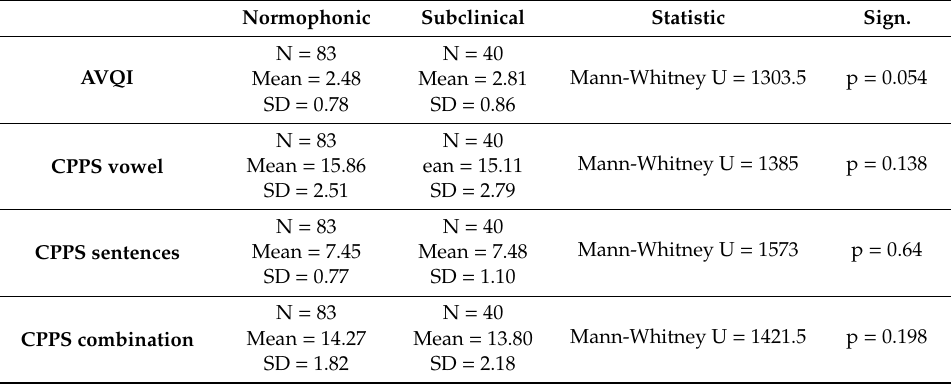
Table 4. Comparison of mean AVQI and CPPS values of subjects with normal versus subclinical dysphonic voice quality with corresponding significance.